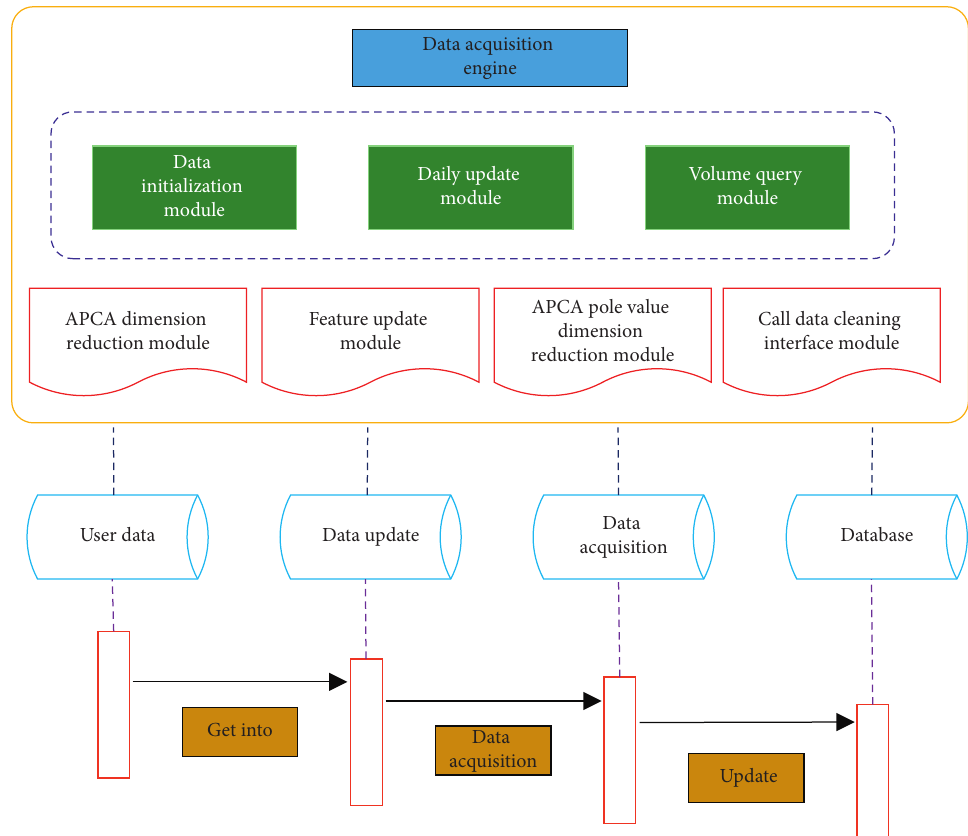
Figure 2: Schematic diagram of data acquisition engine function